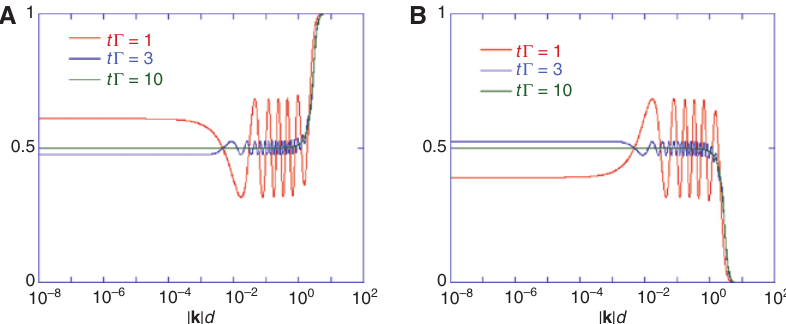
and (B) 〈 b † b 〉/ n as a function of the wavevector component | k | (m −1 ) at different time instants t Γ = 1, 3, and 10 Figure 5: Plot of (A) 〈 a † a 〉/ n 1 1 for d = 5 nm. At time instant t Γ = 10, steady state has been reached.